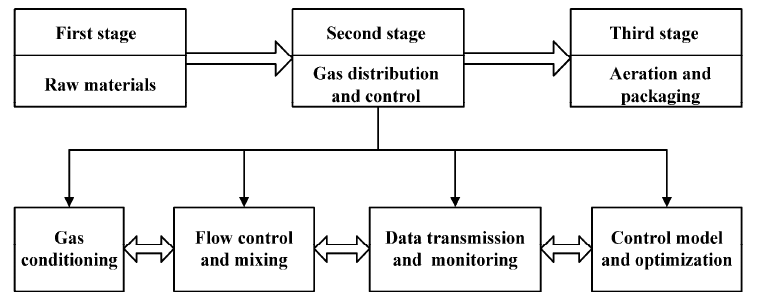
Figure 1. Aquatic product processing and modified atmosphere packaging flow chart.